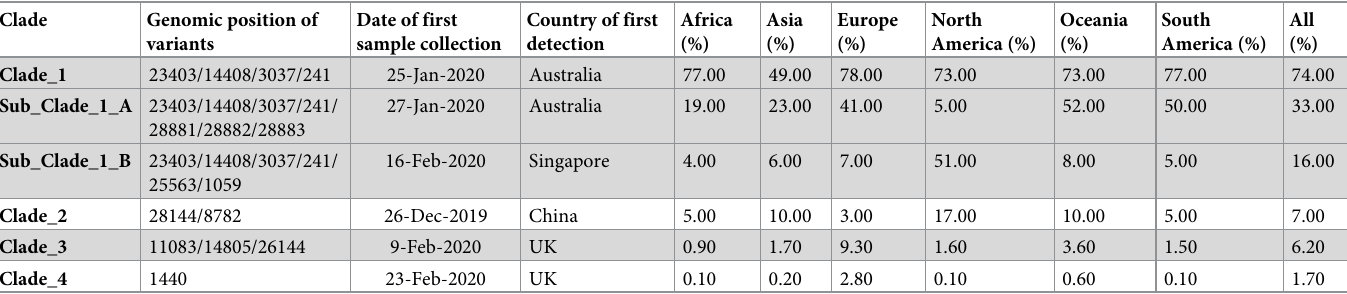
Table 3. Most frequent SARS-CoV-2 clades: Frequency and distribution. Clade Genomic position of Date of first Country of first variants sample collection